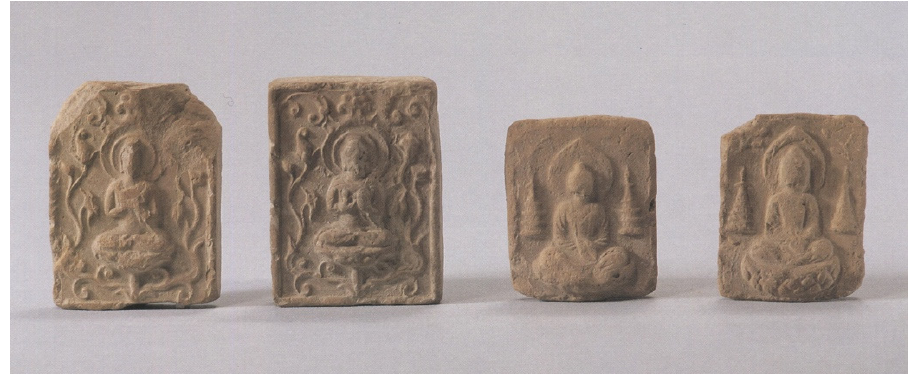
Figure 12. Clay Buddha, Tang Dynasty, ca. 627, 8.8 × 8.8 cm, Nara National Museum, Japan . [©Photograph by Lim, 2019].